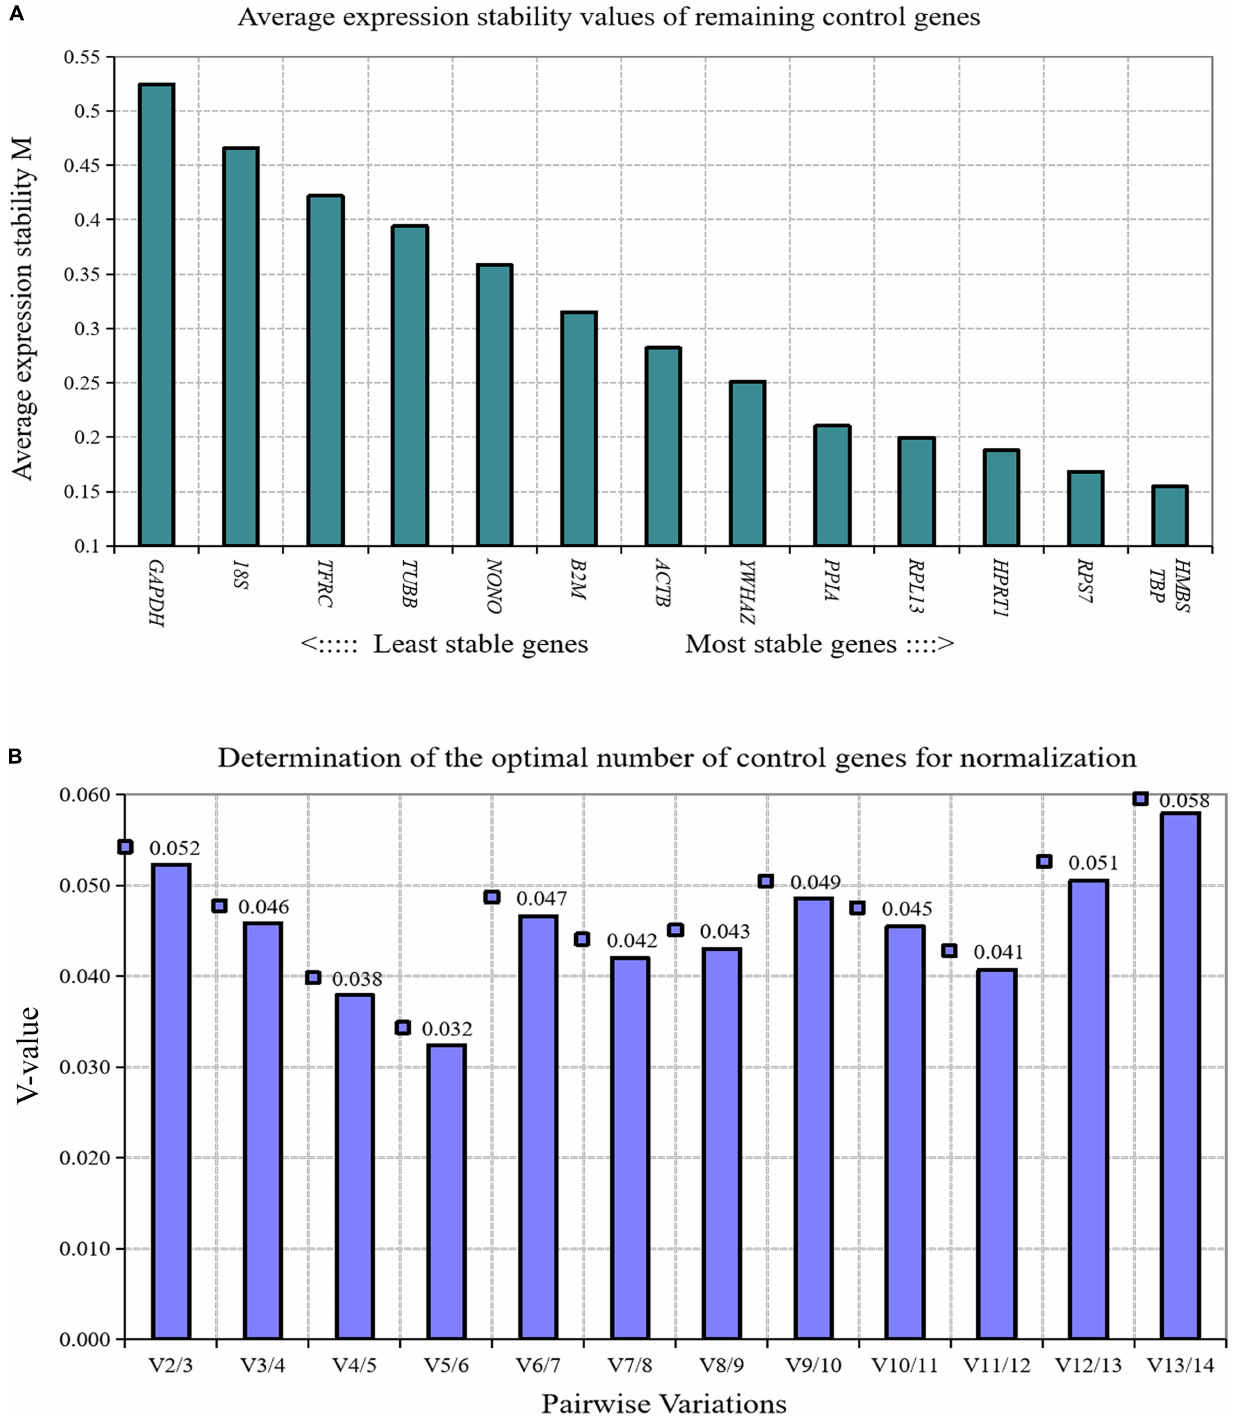
FIGURE 1 | GeNorm analysis of 14 reference genes in broiler abdominal adipose tissue. (A) Expression stability analysis. The most stably expressed genes have lower M values. TBP and HMBS were the two best reference genes; (B) Pairwise variation analysis. Determination of the optimal number of reference genes required for normalization calculated by pairwise variation analysis between normalization factors NF n and NF n + 1 . According to geNorm algorithm, two reference genes were needed.